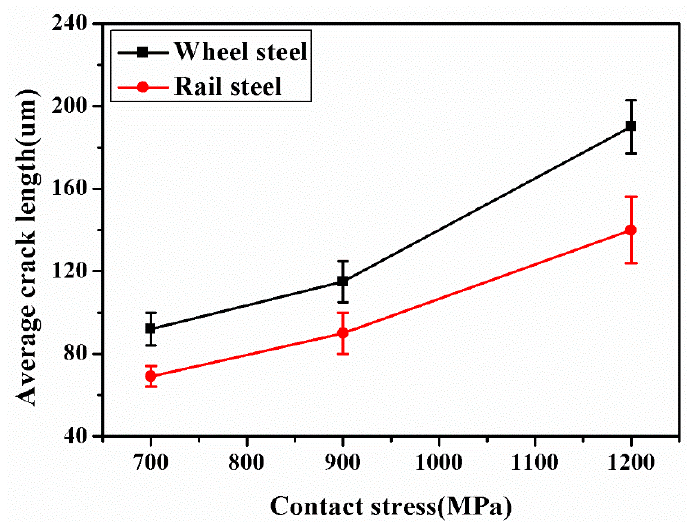
Figure 12. The average crack length of wheel and rail samples under different contact stress conditions. Figure 13 is the schematic diagram of the stress and strain of material during rolling operation.